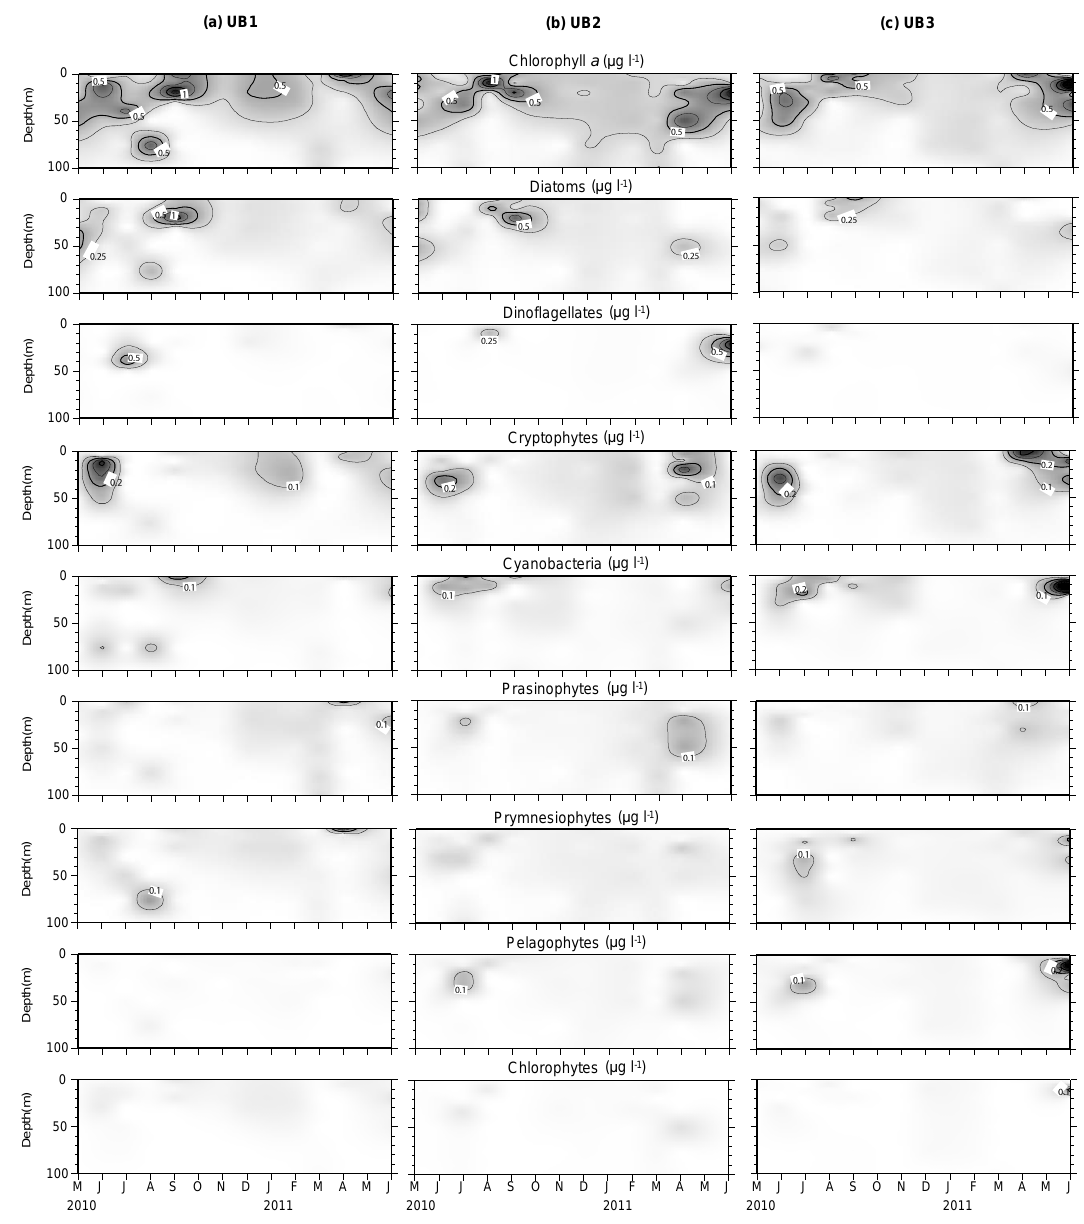
Fig. 5. Contour plots of chlorophyll a and eight phytoplankton groups (diatoms, dinoflagellates, cryptophytes, cyanobacteria, prasinophytes, prymnesiophytes, pelagophytes, and chlorophytes) observed at the three stations during our study period.